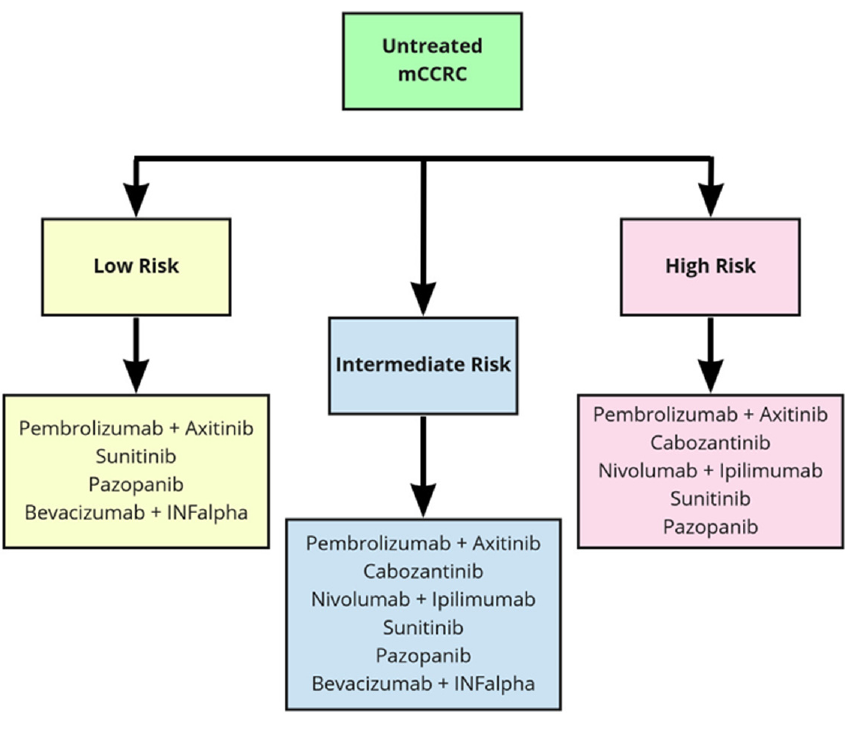
Figure 1. First line therapy in metastatic clear cells renal carcinoma (mCCRC).